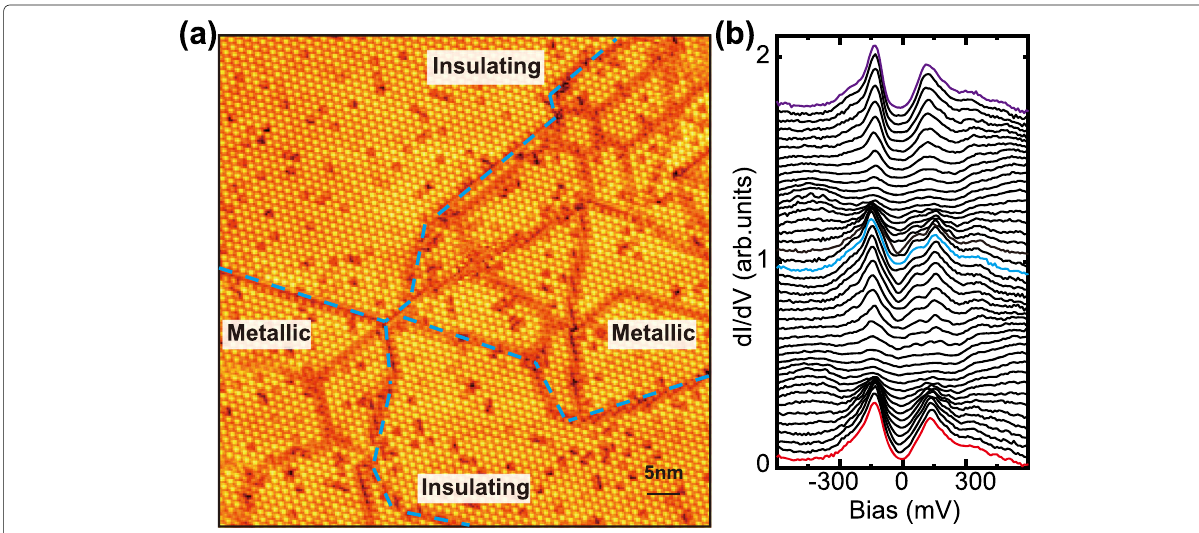
Fig. 9 Topography and electronic state for a x = 0.01 sample of 1 T -Ti x Ta 1 − x S 2 . a A 75 × 75 nm 2 topography shows the coexistence of different domains. b A series of dI / dV spectra measured along three adjacent SDs insides a metallic domain. Taken from ref.